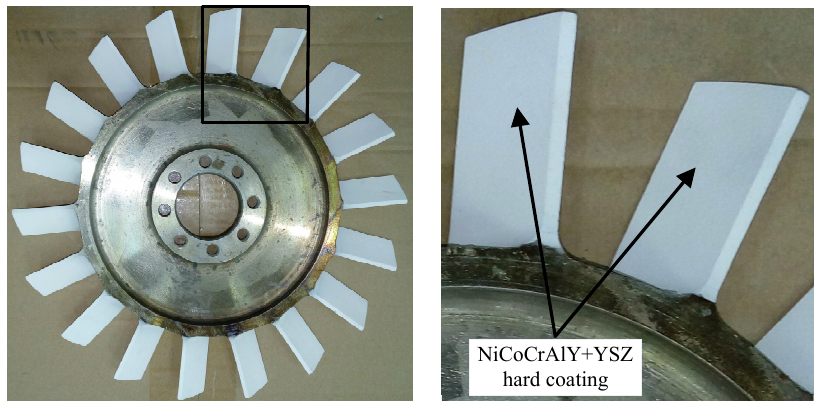
Figure 5. Mistuned blisk with a hard coating of NiCoCrAlY + YSZ.